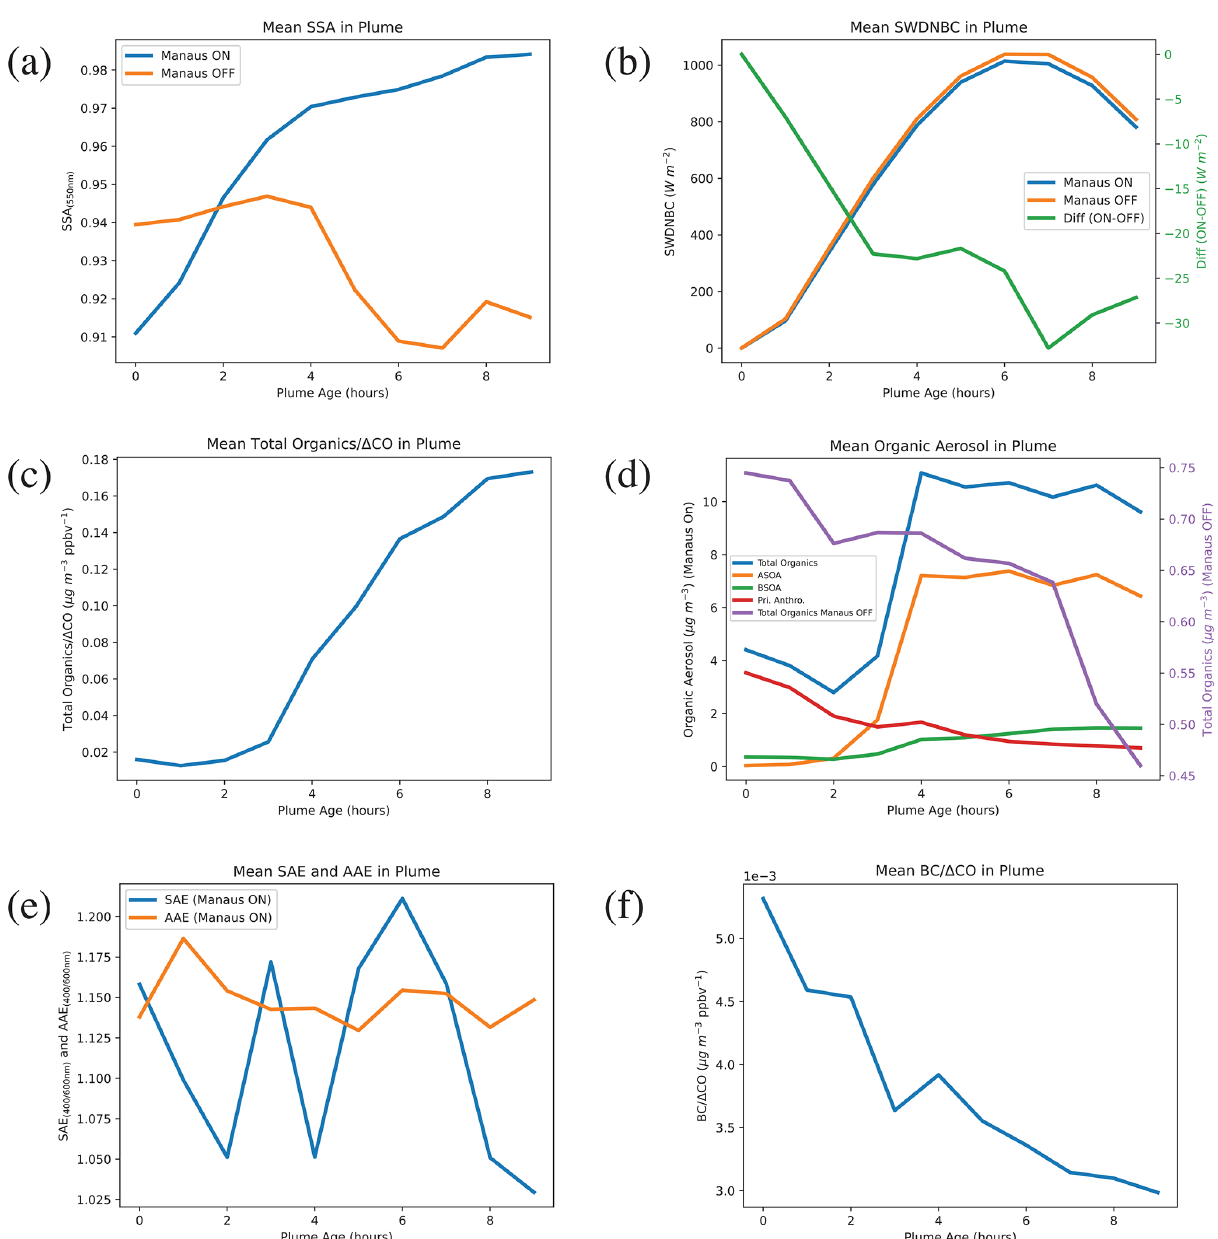
Figure 11. Averaged aerosol concentrations and optical properties within simulated plume between 06:00 and 15:00LT on 13 March 2014. (a) Single scattering albedo (SSA) at 550nm, (b) instantaneous downwelling clear-sky shortwave flux at bottom (watts per square meter), (c) total organics (micrograms per cubic meter) normalized by (cid:49) CO, (d) organic aerosol (micrograms per cubic meter), (e) SAE and AAE and (f) BC (micrograms per cubic meter) normalized by (cid:49) CO. The plume age represents the time the plume tracking started. Tracking was accomplished with the HYSPLIT method described in section